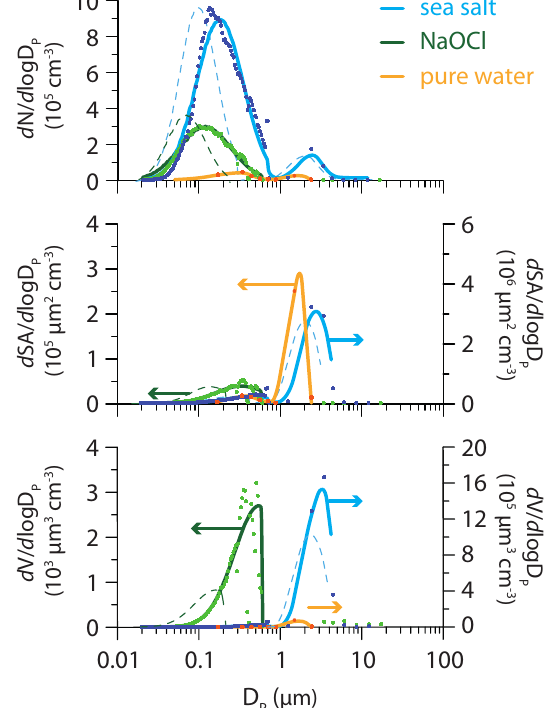
Fig. 2. Size, surface area and volume distributions of aerosol pro- duced from various solutions: synthetic sea salt solution is shown in blue, water is shown in orange and NaOCl solution is shown in green. Individual points represent measurements while solid lines show fits to a log-normal distribution before the aerosol was dried. The log-normal fit following the dryer is shown as a dashed line. The axis on which each aerosol type is plotted is indicated with